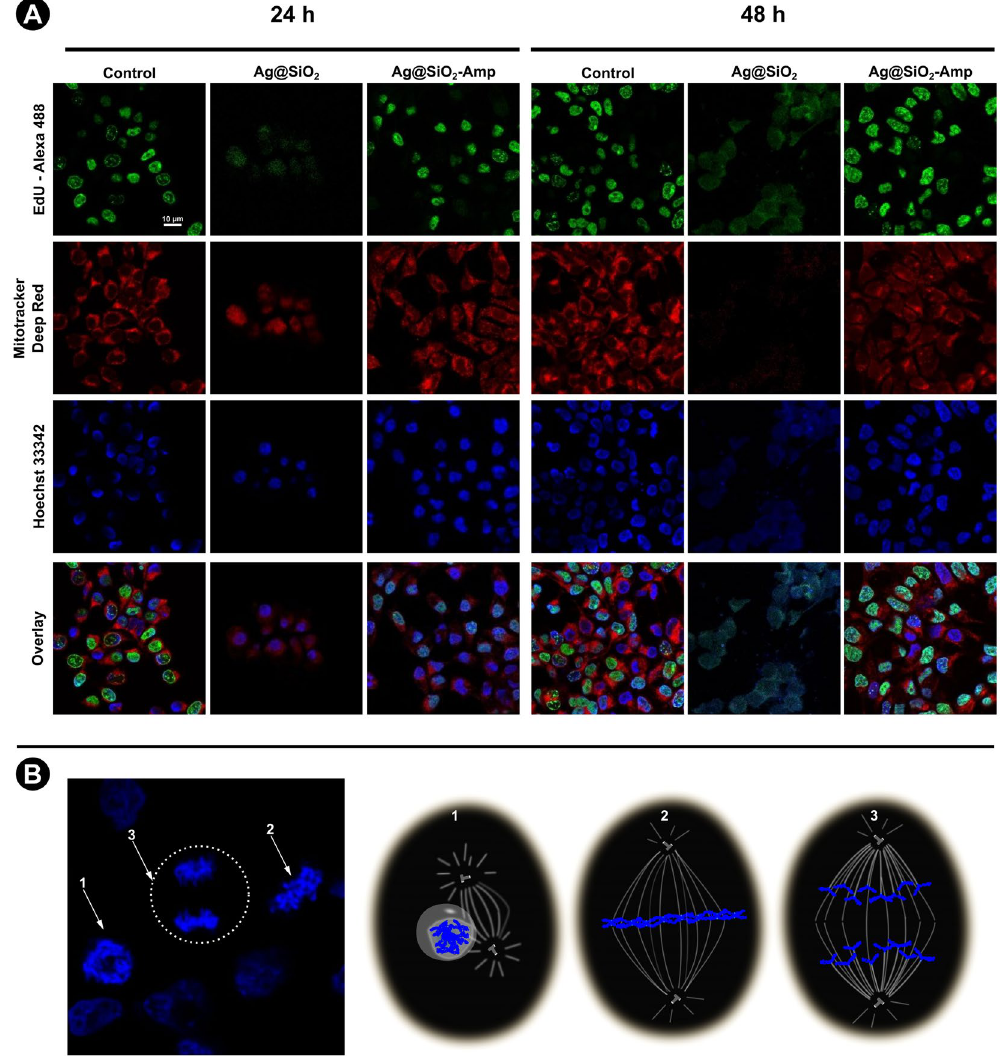
Figure 5. Cells images during the cytotoxicity tests. ( A ) First column in 24 and 48 h treatment corresponds to the control test in absence of nanoparticles, second column corresponds to the cells in the presence of the Ag@SiO 2 and third column corresponds to the cells in the presence of the Ag@SiO 2 -Ampicillin. EdU-Alexa 488 line represents proliferating cells; MitoTracker ® Deep Red line indicates mitochondria in the cytoplasm; Hoechst 33342 line represents the cell nuclei and the last line represents the overlay of the three images for each condition. ( B ) Mitoses phases observed in confocal images. White arrows in confocal image and schemes 1, 2 and 3 represent prophase, metaphase and anaphase, respectively, after 48 h of Ag@SiO 2 -Ampicillin treatment. The schemes are merely illustrative for the phases observed and are not in proportion to the actual size of the